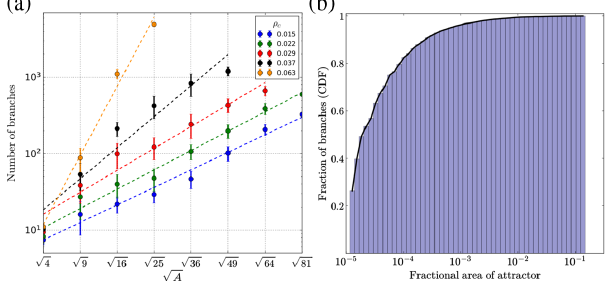
FIG. 4. Large patterns have an exponential number of branches (i.e., minima) of decreasing attractor size. We characterized the landscape by sampling random quadrilateral meshes of size up to A ¼ 81 vertices and folded each one with random torques until no new stable branches were found [ κ f ¼ 10 − 6 ; see Eq. (1)]. (a) Quadrilateral meshes show an exponential number of distinct folding branches (i.e., local minima) in their energy landscape; the precise scaling depends on the total extent of folding ∥ ⃗ ρ ∥ , reflecting the relative importance of bending and stretching energies (Appendix B). (b) The size of attractor basins around different branches for a fixed pattern does not exceed 15% of the total space for a 4 × 4 (b) The attractor size of each distractor branch (taken to